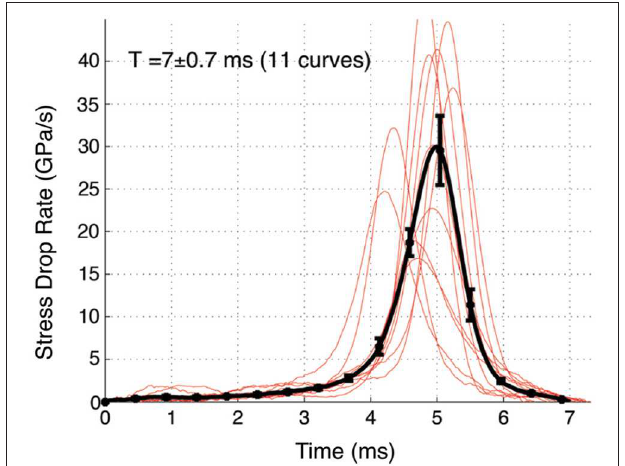
FIGURE 5 | The individual avalanche profiles (in red) as well as the averaged profile (in black) of those “large” avalanches within the bin 7 – 0.7ms ≤ T ≤ 7 + 0.7ms and S ≥ 10 MPa, i.e., avalanches with duration of 7ms ± 0.7ms in the large avalanche regime [Reprinted from Wright et al. [27], with the permission of AIP